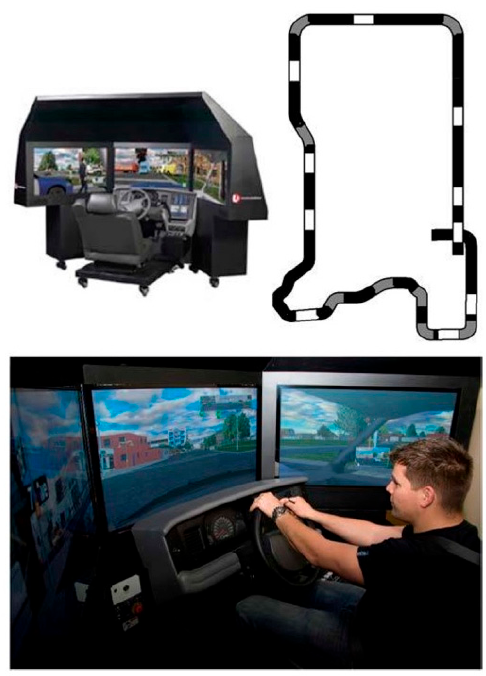
Figure 1. MPRI PatrolSim IV driving training simulator (top left), structure of the 28-mile road course with measured straights in white and measured curves in gray (top right), and a demonstration of driving the simulator in a suburban scenario rather than the rural highway scenario used in these experiments.